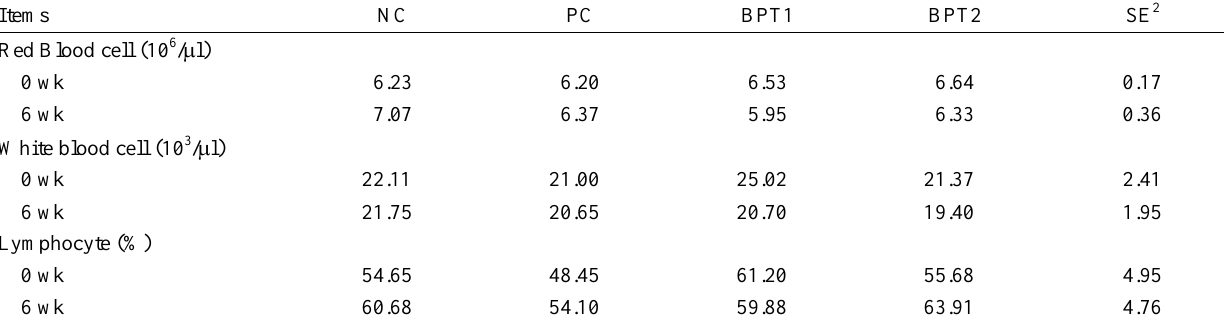
Table 4. Effects of bacterphage on fecal microflora and diarrhea score in growing pigs 1